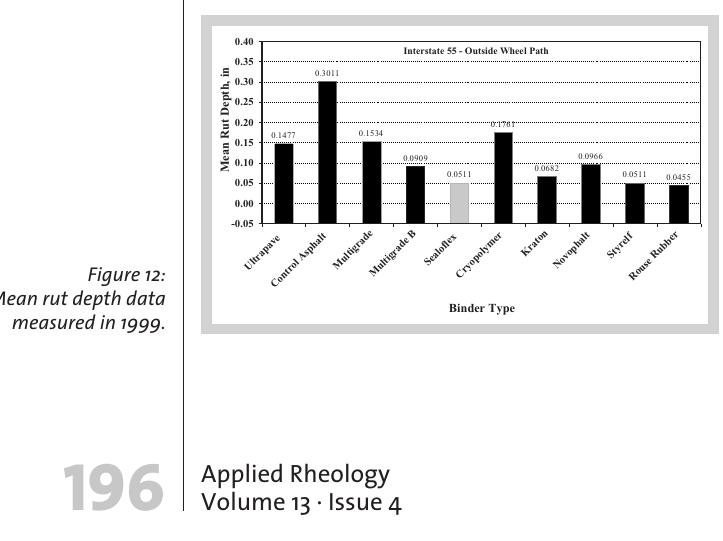
Figure 12: Mean rut depth data measured in